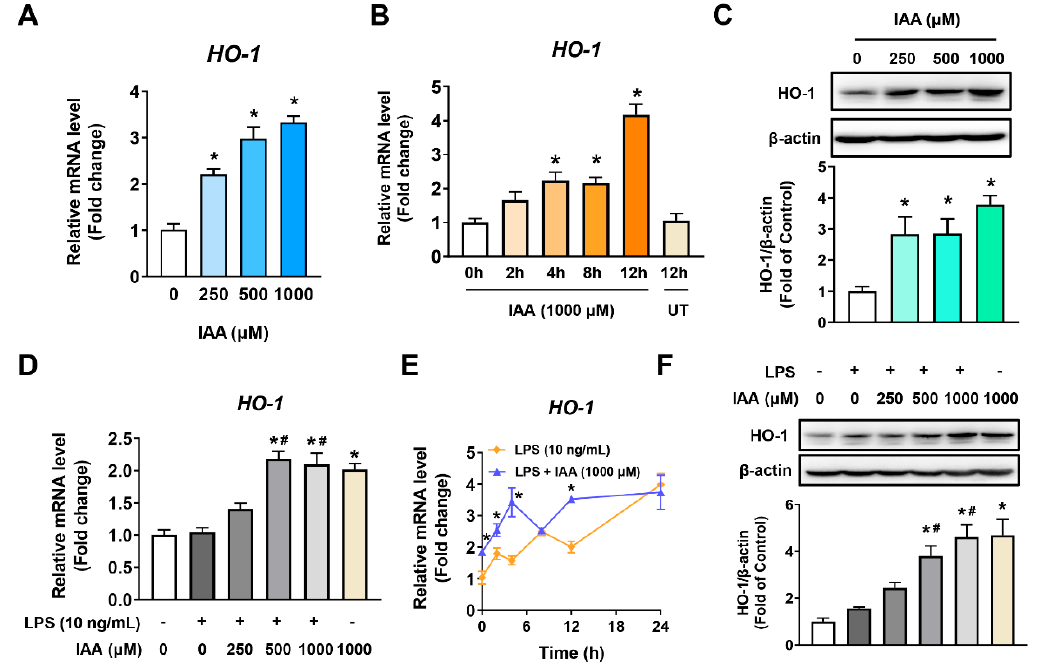
Figure 5. Induction of HO-1 expression in RAW264.7 in response to IAA treatment. Cells were ( A ) treated with di ff erent doses of IAA, as shown for 12 h, or ( B ) exposed to 1000 µ M of IAA for indicated time points, followed by RT-qPCR analysis for HO-1 mRNA. β -actin was considered as the reference. Results are shown as mean ± SEM. n = 3. * p < 0.05 versus control group. ( C ) Western blot analysis of HO-1 protein. Cells were incubated with indicated concentrations of IAA for 12 h. β -actin was regarded as the loading control. Bar chart are mean ± SEM. n = 3. * p < 0.05 versus control group. ( D ) Cell were incubated with medium-containing di ff erent concentrations of IAA for 12 h, after which cells were stimulated with LPS for 8 h and then analyzed by RT-qPCR. Values are shown as mean ± SEM. n = 3. * p < 0.05 versus control group; # p < 0.05 versus LPS group. ( E ) Time-course analysis of HO-1 mRNA in response to LPS or LPS plus IAA treatment. Results are described as mean ± SEM. n = 3. * p < 0.05 versus LPS group. ( F ) Cells pretreated with IAA for 12 h were subjected to LPS (10 ng / mL) incubation for 16 h before Western blotting. β -actin was considered as the loading control. Results are shown as mean ± SEM. n = 3. * p < 0.05 versus control group. # p < 0.05 versus LPS group. HO-1,